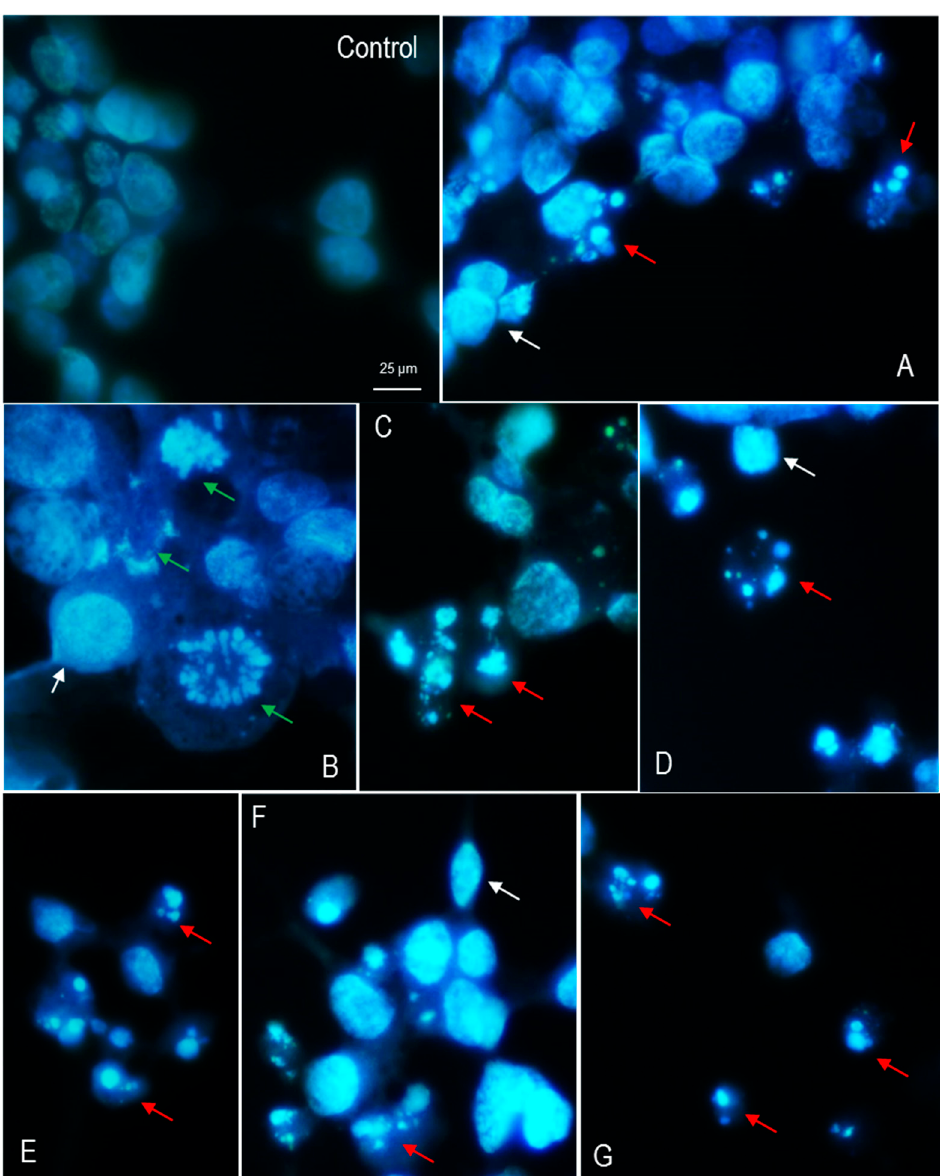
Figure 3. Nuclear morphology of LMH cells stained with DAPI (4’,6-diamidino-2-phenylindole) after 48h exposure to 0.03% ammonia ( A – C ), dimethylamine ( D , G ) and trimethylamine ( E , F ). Condensation of nuclear material (white arrows), apoptotic bodies (red arrows), cell swelling and chromatin lysis (green arrows) were observed. Fluorescence microscopy (Nikon, Tokyo, Japan); 1000 × magnification. Images are representative of two independent experiments .